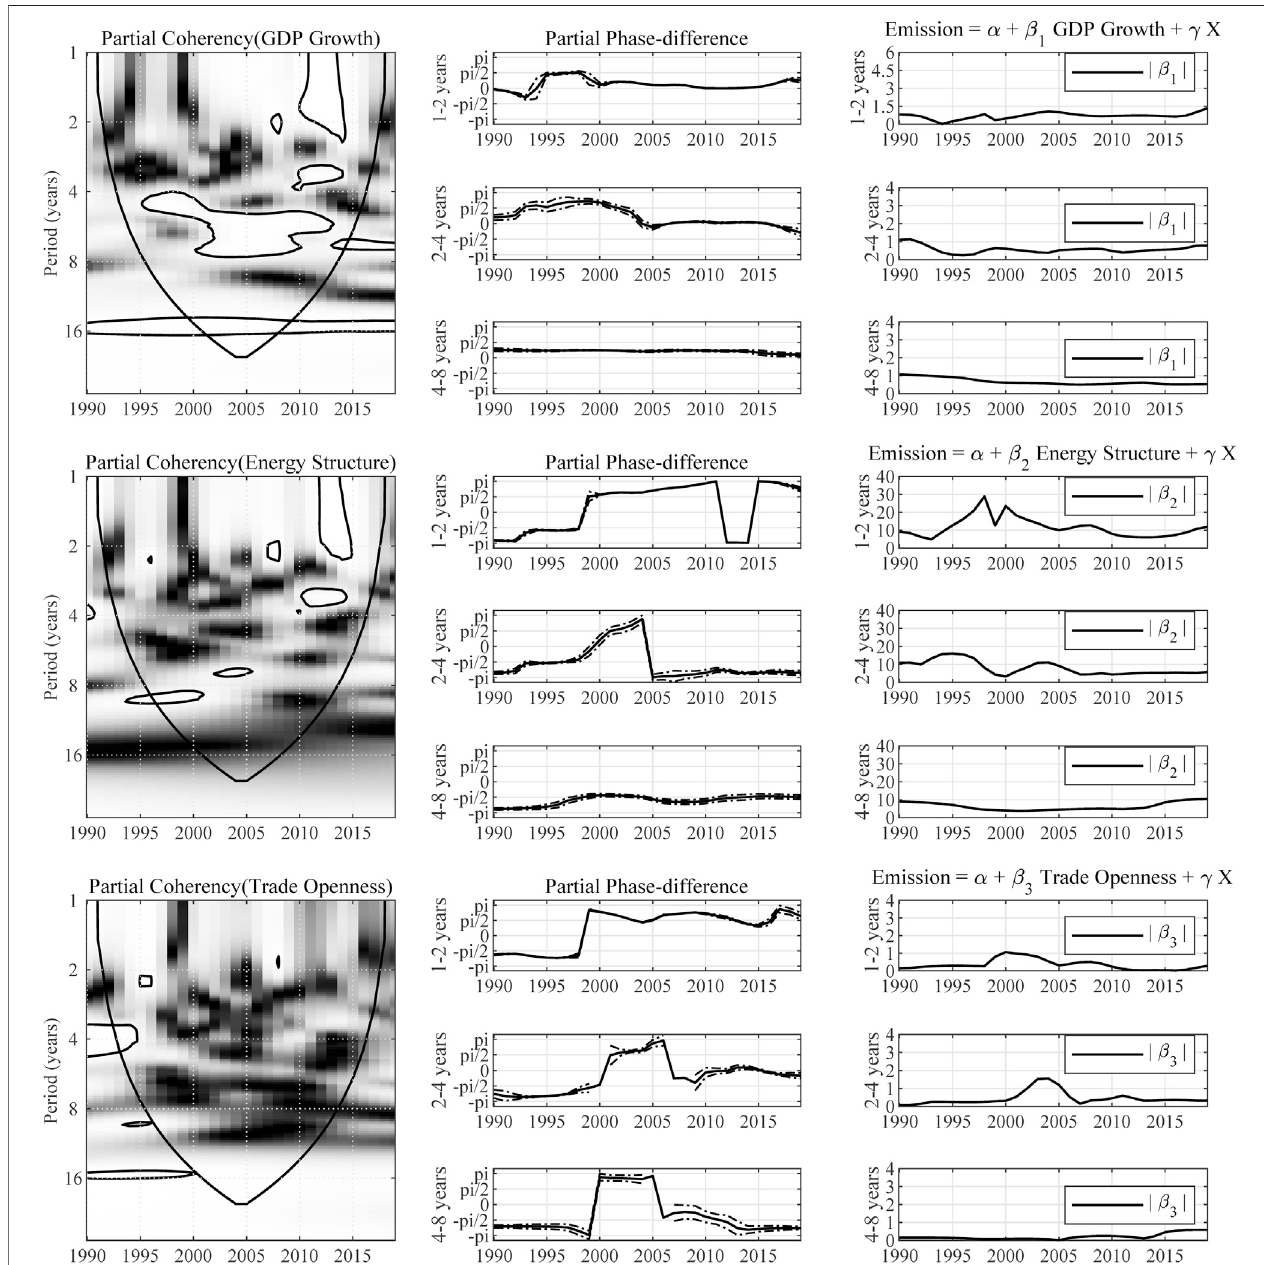
FIGURE 6 | Multivariate wavelet analysis results for Russia. Note: The expression “ Partial Coherency (Z) ” denotes the partial coherency between variable Z and carbon emission,controlledforthein fl uencefromotherfactors.Theareas belowthesymmetricblackconvexcurvethatappearsinthe fi gureofcoherencyarecalledthe “ Cone of In fl uence (COI), ” in which the edge effects are profound. Inside the COI, the results tend to be unreliable. The contours in the coherency diagrams indicate 5% signi fi cance level, bootstrapped for 10,000 replications. And, the brighter colors correspond to higher signi fi cance level, and darker colors correspond to lower signi fi cance level. The dotted lines accompanying the partial phase-difference indicate the 95% con fi dence intervals.